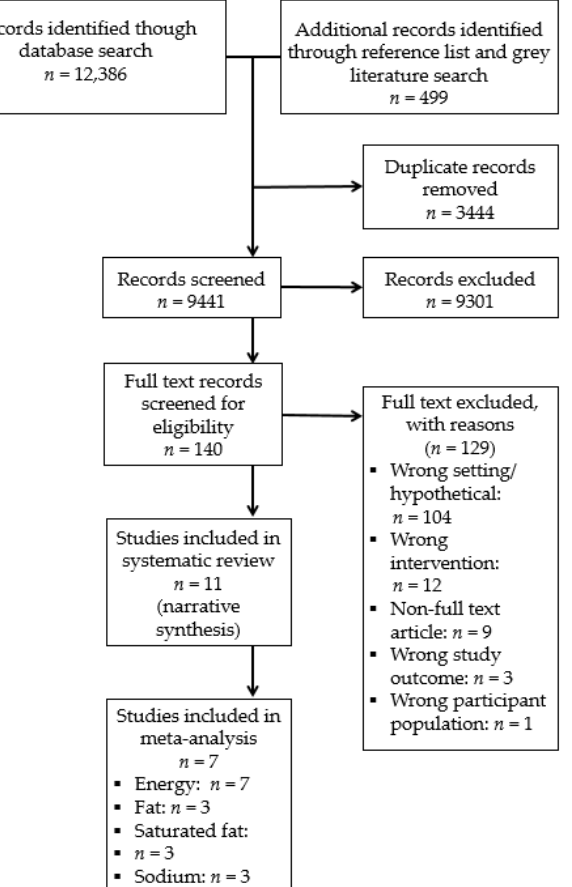
Figure 1. PRISMA flow diagram of included studies.